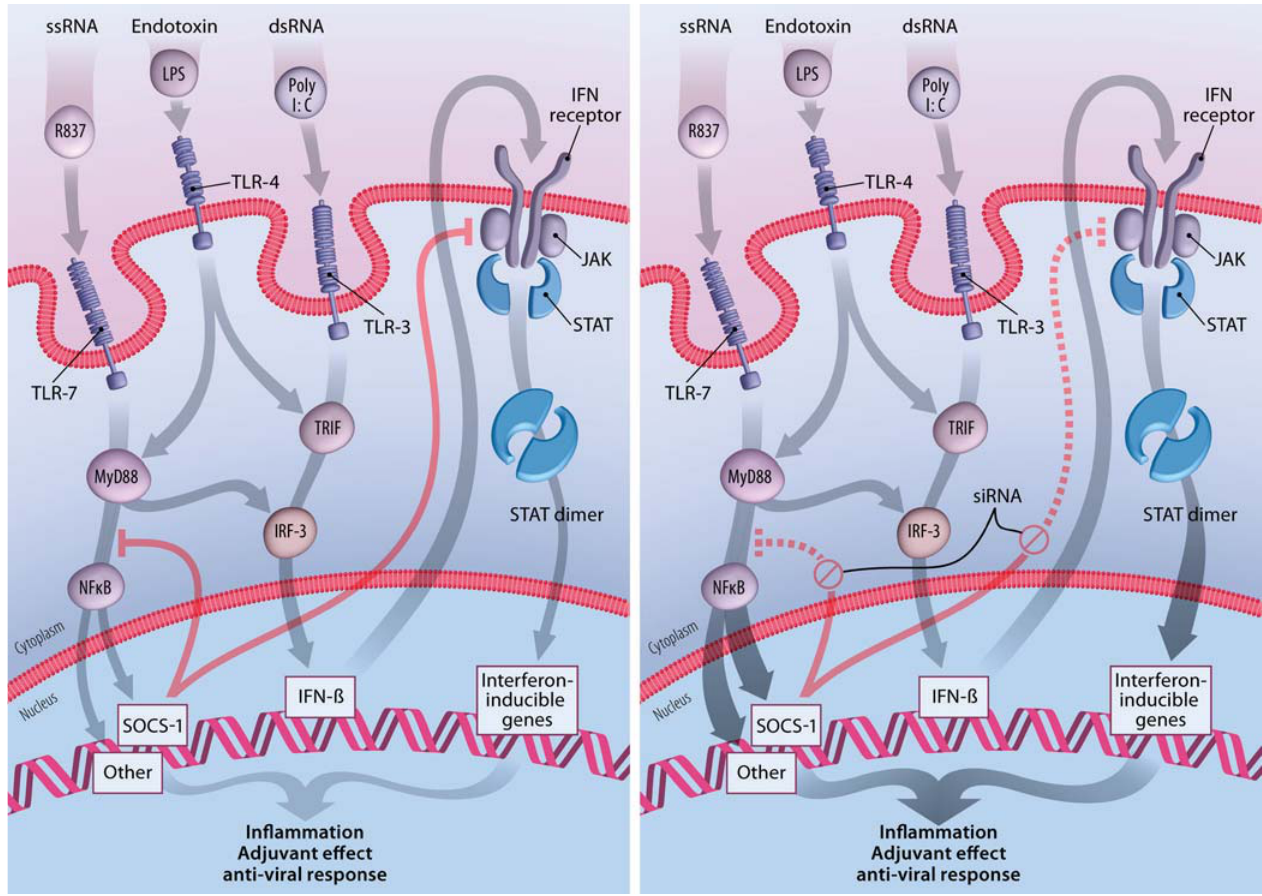
Figure 1. SOCS “Silencing” Enhances the Adjuvant Effect of TLR Ligands Substances common in viral pathogens (substances such as single-stranded RNA [ssRNA] and double-stranded RNA [dsRNA]) or in bacteria (substances such as endotoxin) are recognized by TLRs as pathogen-associated molecular patterns. When the TLRs are triggered, a series of signaling events occur that is simplifi ed and schematized in this fi gure. These events lead to infl ammation and activation of innate and adaptive immune responses. SOCS family members are also activated, and serve as an internal control to diminish the intensity and duration of infl ammation. In the left-hand panel, R837 mimics ssRNA as a ligand for TLR-7, and initiates signaling through the MyD88 pathway, eventually resulting in the release of NF- κ B and in the upregulation of SOCS1 and many genes involved in infl ammation. PolyI:C is a synthetic mimic of dsRNA and triggers TLR-3-associated JAK/signal transduction and activator-of-transcription (STAT) signaling through TIR domain-containing adapter-inducing interferon (TRIF), activation of interferon regulatory factor (IRF)-3, and increased production of type 1 interferon. LPS can activate both pathways. SOCS1 specifi cally interferes with JAK2 and may also inhibit a step between MyD88 and NF- κ B release into the nucleus, although this is controversial. This balanced internal feedback mechanism results in a controlled infl ammatory process with adjuvant and antiviral effects. When SOCS1 production is blocked by siRNA (right-hand panel), the control of the infl ammatory process is temporarily lost, leading to a greater adjuvant and antiviral response that appears to improve vaccine-induced immune